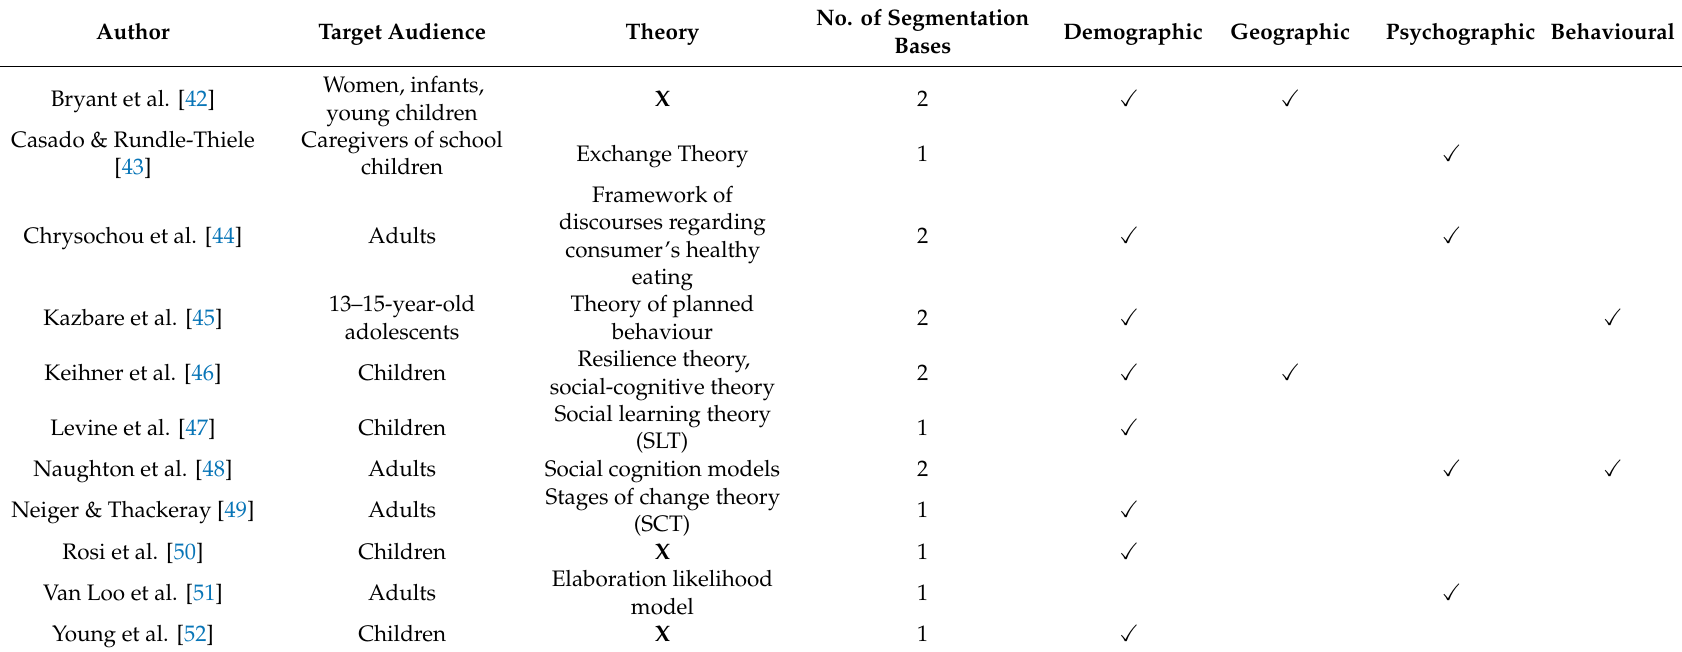
Table 1. Social marketing segmentation studies encouraging healthful eating